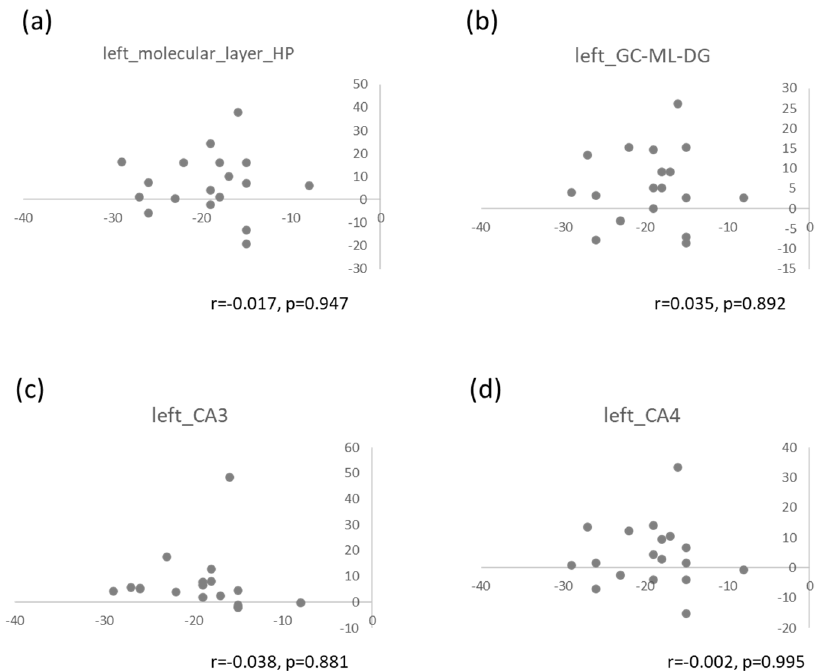
Figure 4. Di ff erence in the HAMD score and in the volume of the left molecular layer ( a ), left GC-ML-DG ( b ), left CA3 ( c ), and left CA4 ( d ). X-axis shows the di ff erence of the HAMD score baseline and 6 months; Y-axis shows the di ff erence of volume (mm 3 ) at baseline and 6 months.